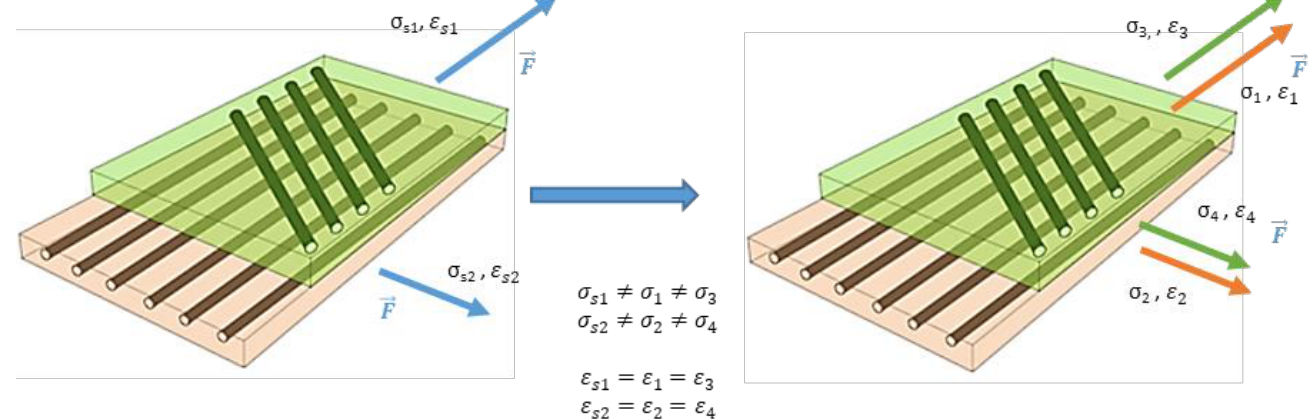
Figure 5. Schema showing the relationship between plies strains within a laminate.